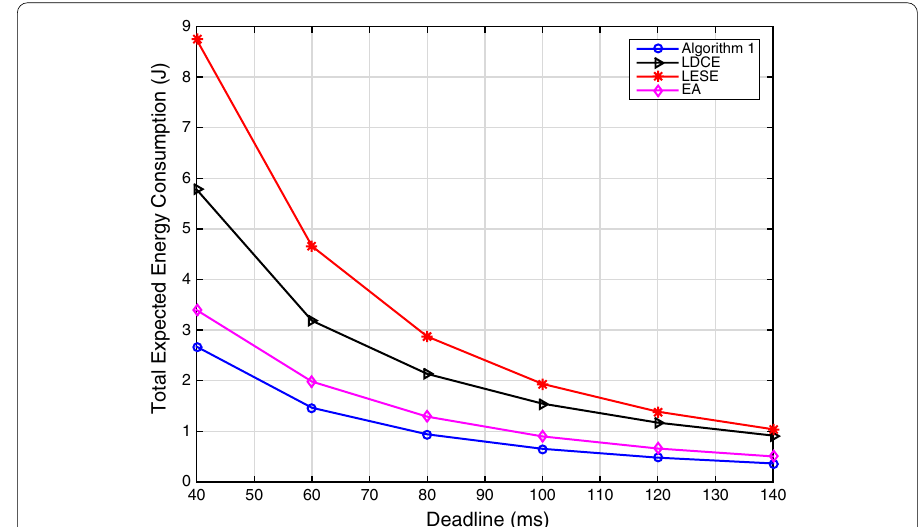
Fig. 4 Total expected energy consumption versus application deadline